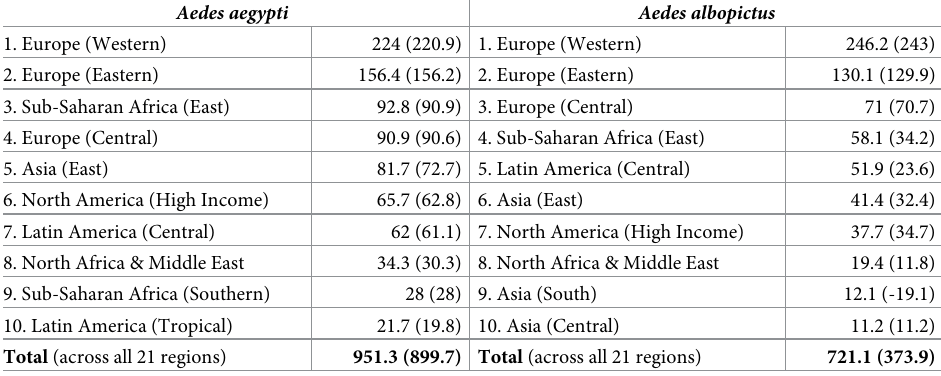
Table 3. Top 10 regional increases in overall populations experiencing temperature suitability for transmission (for one or more months). Regions are ranked based on millions of people exposed for the first time to any transmis- sion risk; parentheticals give the net change (first exposures minus populations escaping transmission risk). All values are given for the worst-case scenario (RCP 8.5) in the longest term